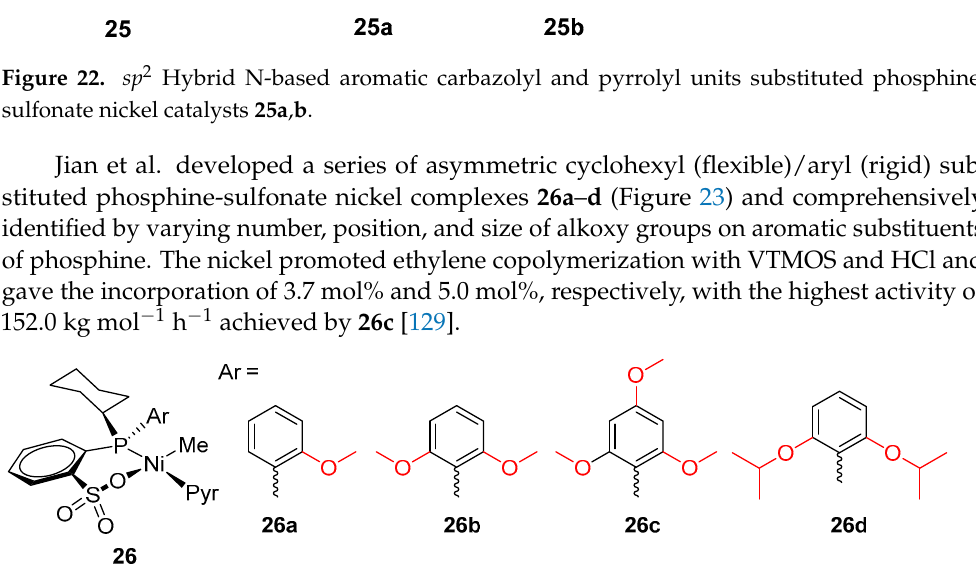
Figure 23. Flexible cyclohexyl/rigid aromatic phosphine-sulfonate nickel catalysts 26a – d